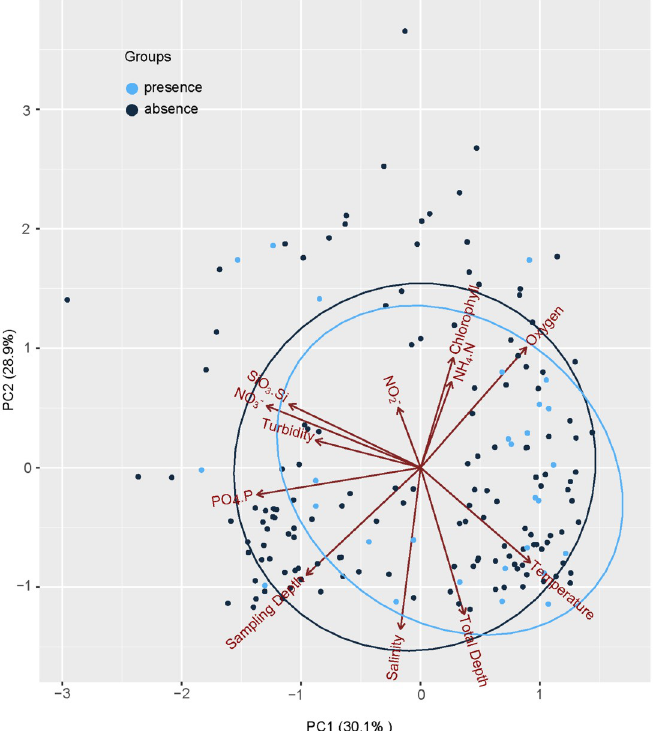
Fig 5. The Principal Component Analysis (PCA) results of environmental variables (total depth, sampling depth, temperature, salinity, chlorophyll, oxygen, turbidity, PO 4 .P, NH 4 .N, SiO 3 .Si, NO 3- , and NO 2- ) of small yellow croaker sampling stations in the East China Sea. Dots indicate sampling stations, and circles indicate groups. Light blue: the presence of small yellow croaker detected by eDNA and dark blue: the absence of small yellow cracker, i.e., no species-specific eDNA detected. Two principal components were extracted and presented. PC1 explained 30.1%, and PC2 explained 29.8%. PC1 mostly represented nutrition, and PC2 represented sampling locations and layers in the current